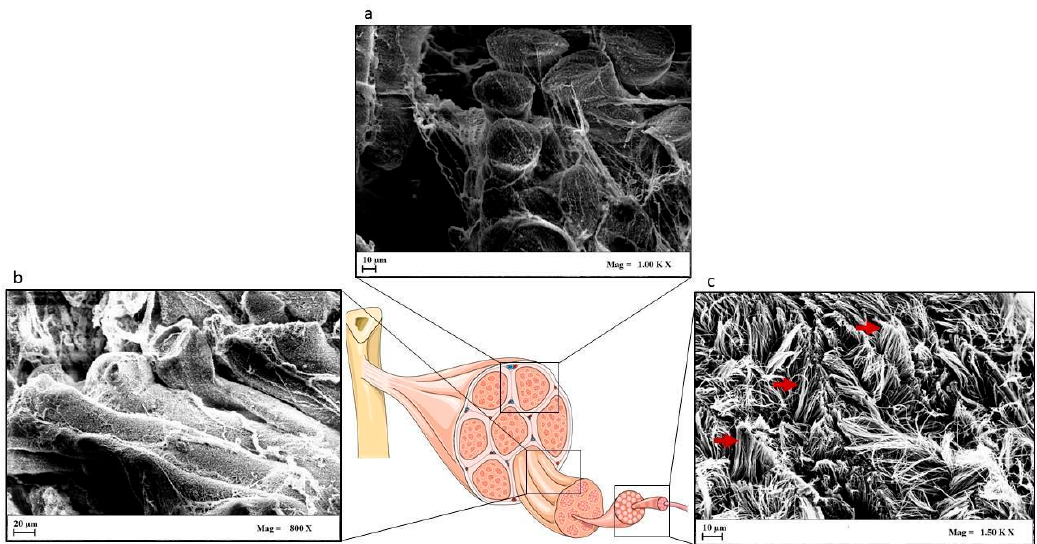
Figure 2. Hierarchical arrangement of the structure of tendons: ( a ) Scanning electron microscopy (SEM) of a transverse section of collagen fiber bundles (scale bar = 10 µ m); ( b ) SEM image of longitudinal collagen bundles in which their parallel arrangement along the longitudinal axis of the tendon is clearly shown; each collagen bundle is surrounded by the endotenon (scale bar = 20 µ m); ( c ) SEM image that shows the multiple collagen fiber bundles that make up the tendon. The sample has been cross-sectioned, but it is clearly evident the parallel orientation of the collagen fibers (red arrows) (scale bar = 10 µ m). Tendon images were obtained by field emission-scanning electron microscopy (FE-SEM, mod. LEO 1525; Carl Zeiss, Oberkochen, Germany). Samples were fixed in 4% paraformaldehyde (PFA), dehydrated with critical point dryer (mod. K850 Emitech, Assing, Rome, Italy), and cut before to be coated with a gold (250 Å thickness) using a sputter coater (mod.108 Å; Agar Scientific, Stansted, UK), courtesy of Giovanna Della Porta and Electron Microscopy Labs at Dept. of Industrial